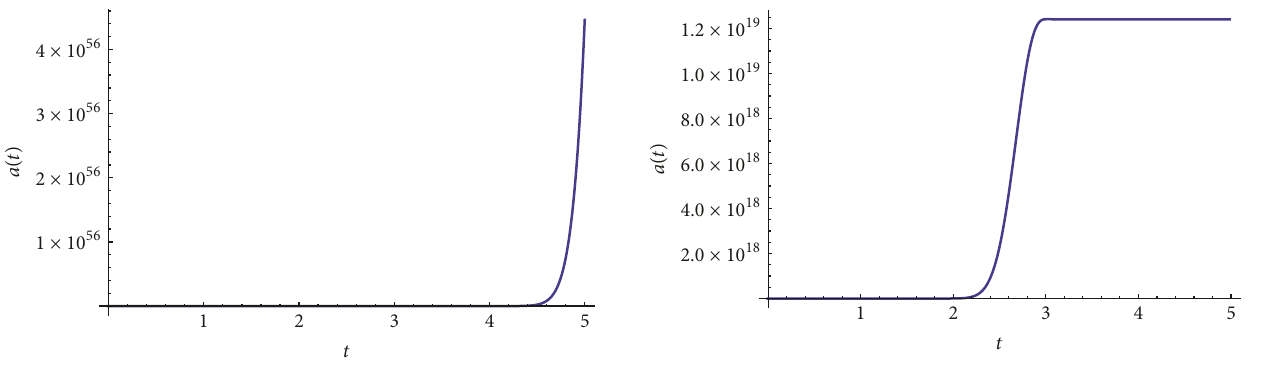
Figure 2: Numerical profile of 𝑎(𝑡) with initial conditions 𝑎(0) = 10 −20 , ̇𝑎(0) = 10 −20 , ̈𝑎(0) = 10 −17 , 𝛽 = −200 , and 𝑘 = 0 .